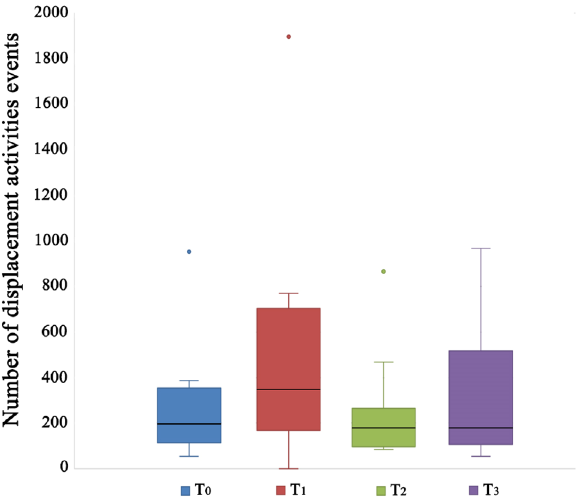
Figure 5. Displacement activities of dogs treated with cannabidiol (CBD) at the start of the study (T 0 ), after 15 (T 1 ) and 45 (T 2 ) days from the beginning of the treatment, and 15 days after the end of administration of CBD (T 3 ). The black bars within the box plots indicate the median; the dots represent the